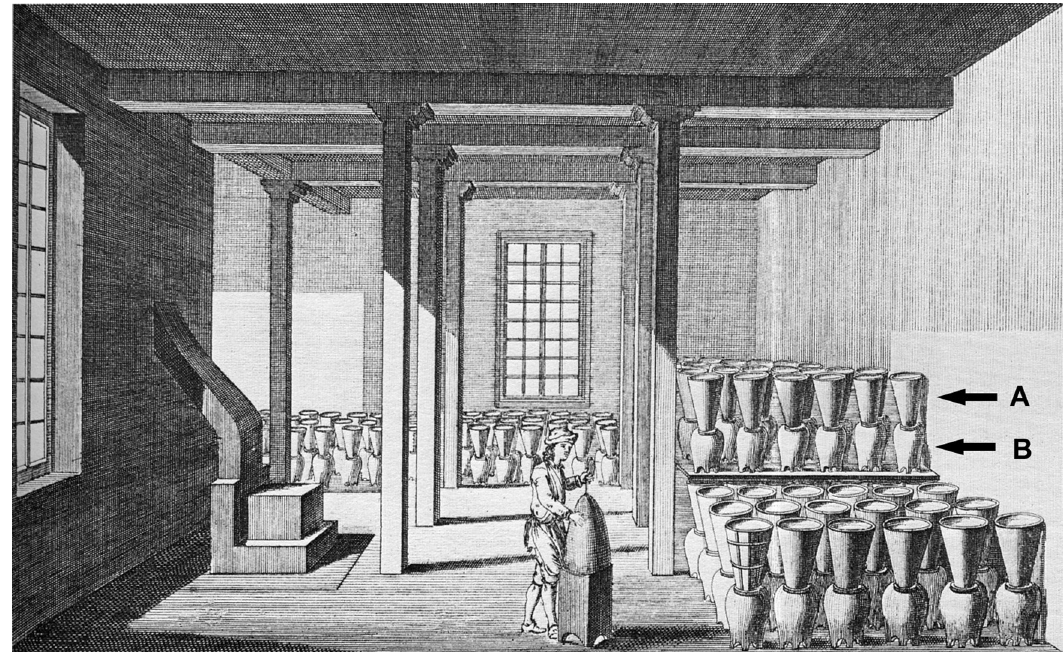
Figure 20: Eighteenth - century cane sugar purging house in the Caribbean, showing the use of ceramic vessels like those shown in Figure 19. ( a ) Vessels called forms, with a rounded, perforated base; ( b ) recipients for the syrup, with a closed fl at base. Modi fi ed after Barrett ( 1970, Figure 13 )